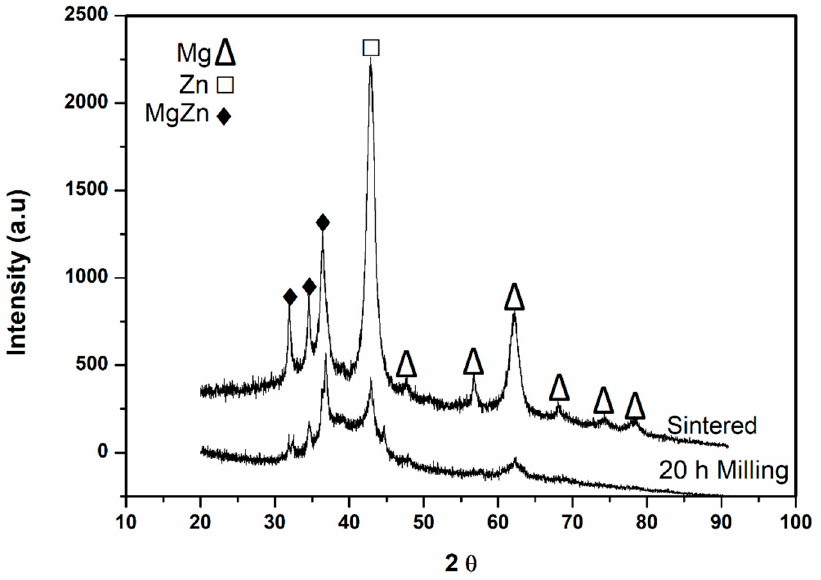
Figure 8. XRD patterns of the Mg65–Zn30–Ca5 obtained and the powders milled for 20 h.